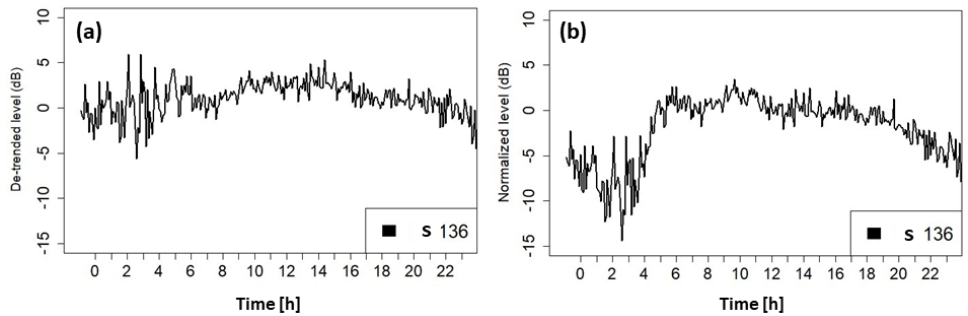
( 1 h ) ( t , s ) profiles for the monitoring station s 136 on a typical day, for the Figure 10. Normalized L eq integration time τ = 5 min [92,93]: ( a ) P1 procedure; ( b ) P2 procedure. The median correlation coefficients obtained for P1 and P2 are shown in Figure 11, as a function of time interval τ . The reported ‘error’ bands correspond to the median absolute deviation, MAD = | x i − ˜ X | , where ˜ X = median ( X ) and X ≡ ( x 1 , . . . , x n ) is a generic time series.